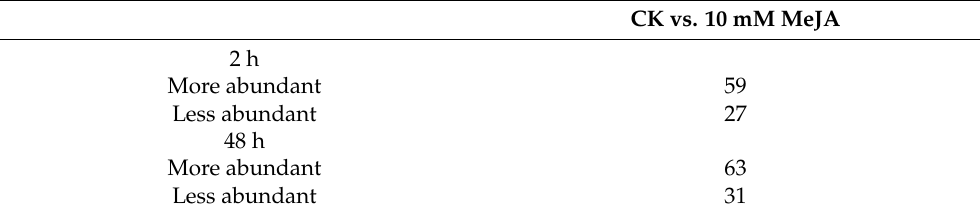
Table 1. Differentially accumulated metabolites of C. vietnamensis leaves in response to MeJA in the negative and positive ion modes.